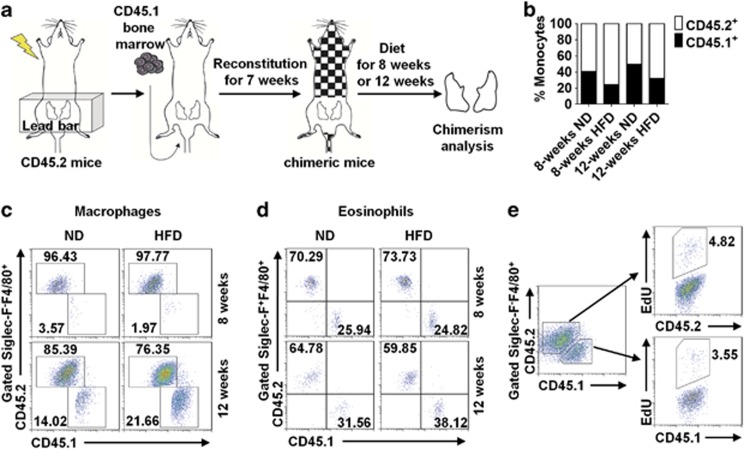
In situ proliferation dominates the initiation of ATM accumulation during obesity. (a) Schematic representation of fat-shielded irradiation and bone marrow transplantation. CD45.2 mice were shielded with lead above the abdomen before lethal irradiation, transplanted with CD45.1 bone marrow, left for reconstitution for 7 weeks, and subjected to diet treatment for 8–12 weeks. Chimerism analysis was performed on leukocytes in blood and eAT. (b) Percentage of chimerism in blood monocytes (CD11b+CD115+) from chimeric mice subjected to ND or HFD for either 8 or 12 weeks. (c) Contribution of CD45.1 donor-derived macrophages to ATM accumulation was analyzed on chimeric mice fed with ND or HFD for 8 or 12 weeks. (d) Contribution of CD45.1 donor-derived eosinophils to adipose tissue eosinophils was analyzed on chimeric mice subjected to ND or HFD for 8 or 12 weeks. The representative results shown in panels (b, c, and d) were from the same group of chimeric mice. (e) Flow cytometric analysis of EdU incorporation in ATMs from chimeric mice on HFD for 12 weeks